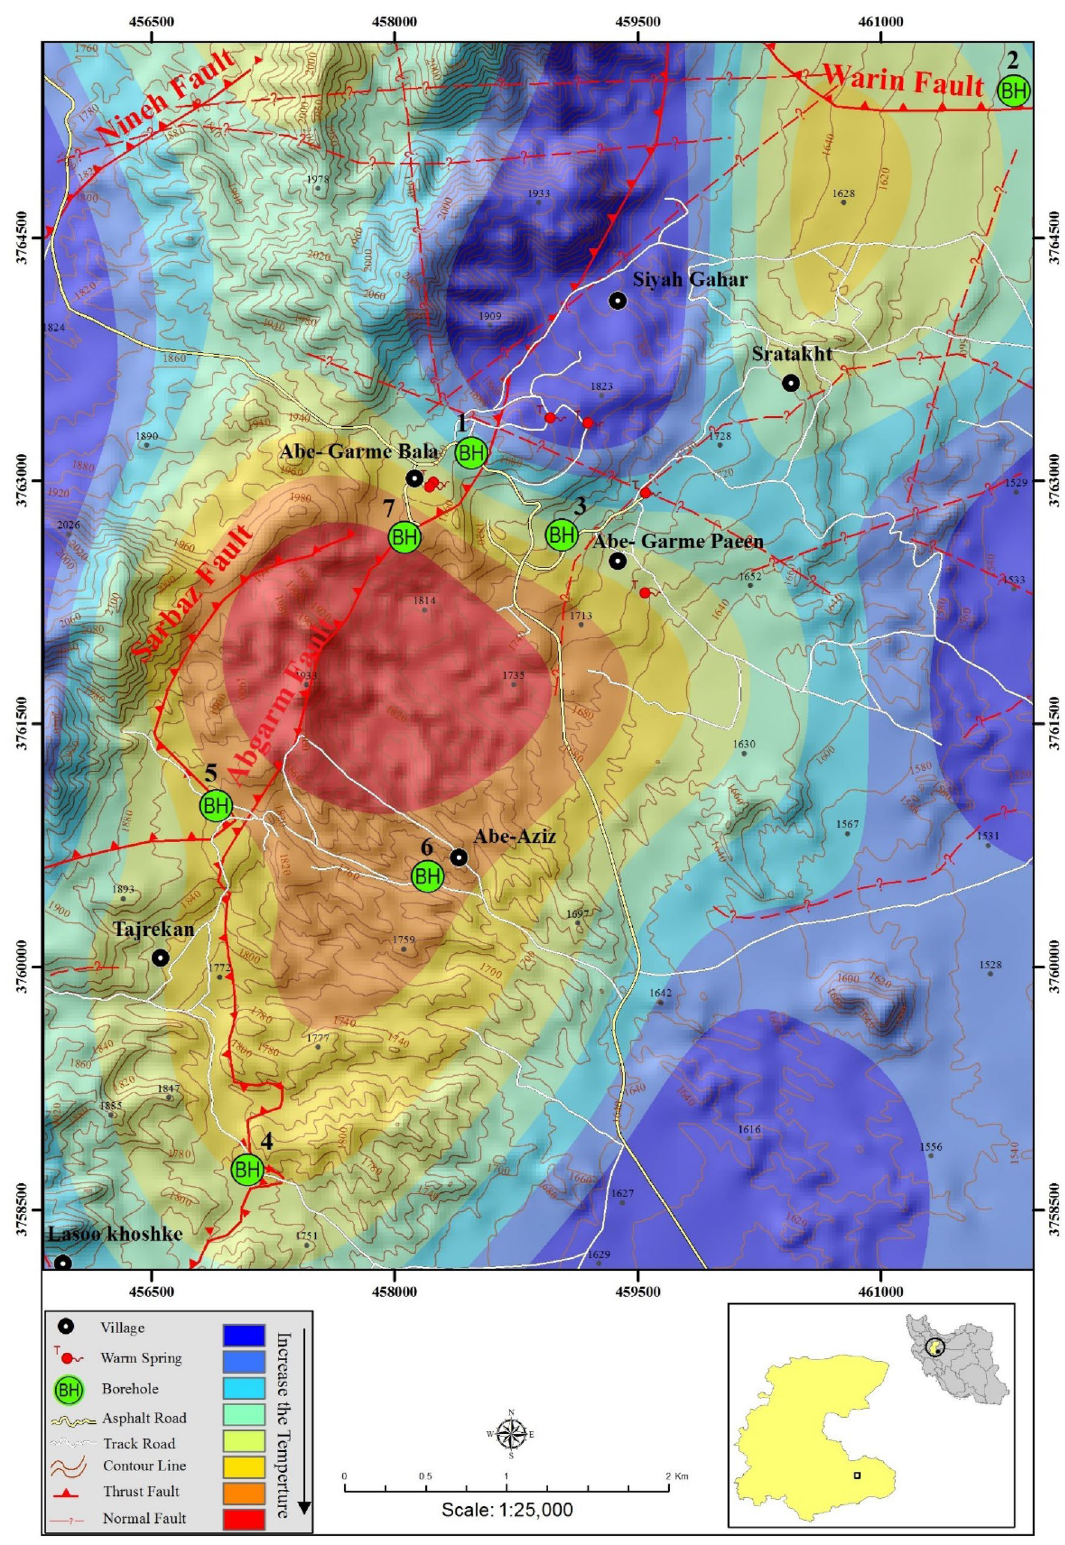
Figure 9. Temperature map at 50 m depth in the gradient wells (photo generated by ArcGIS